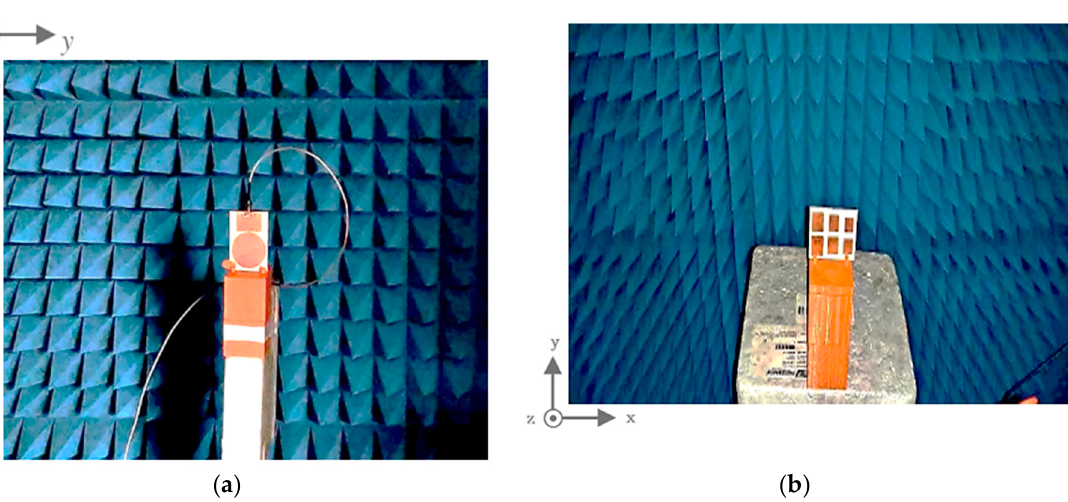
Figure 10. Experimental setup in an anechoic chamber with (a) the reader antenna and (b) the chipless tag, on their sup- ports.